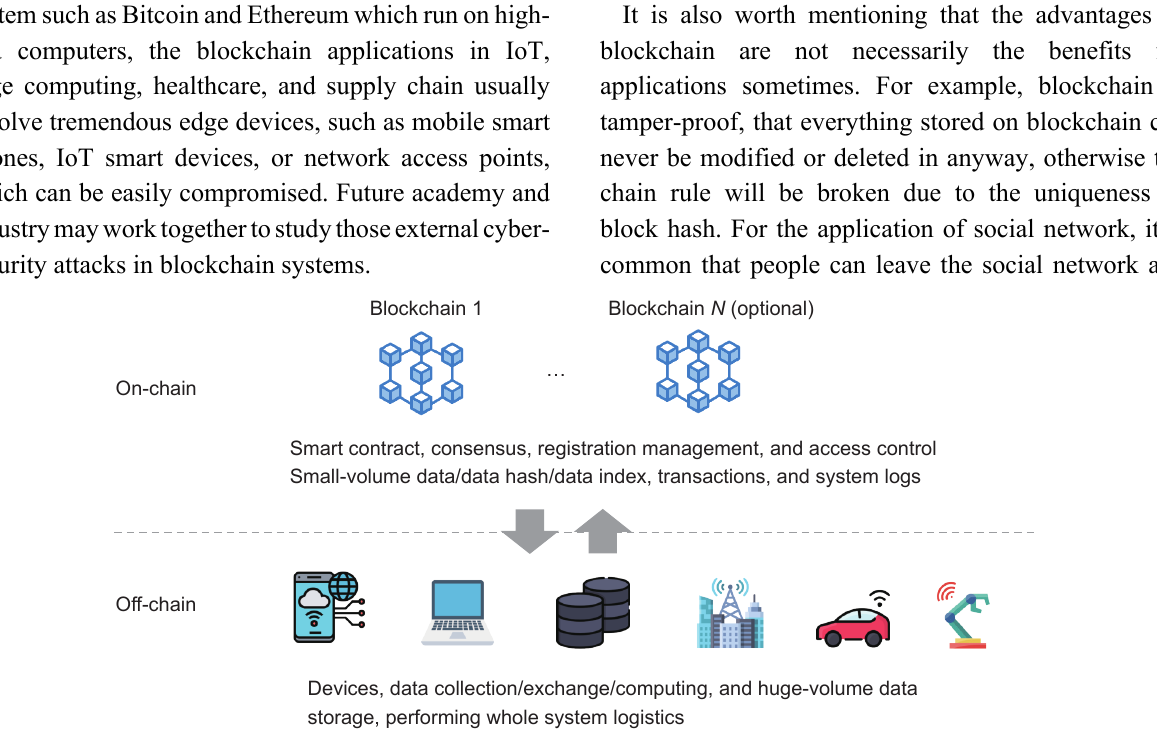
Fig. 10 On-chain/off-chain architecture of blockchain